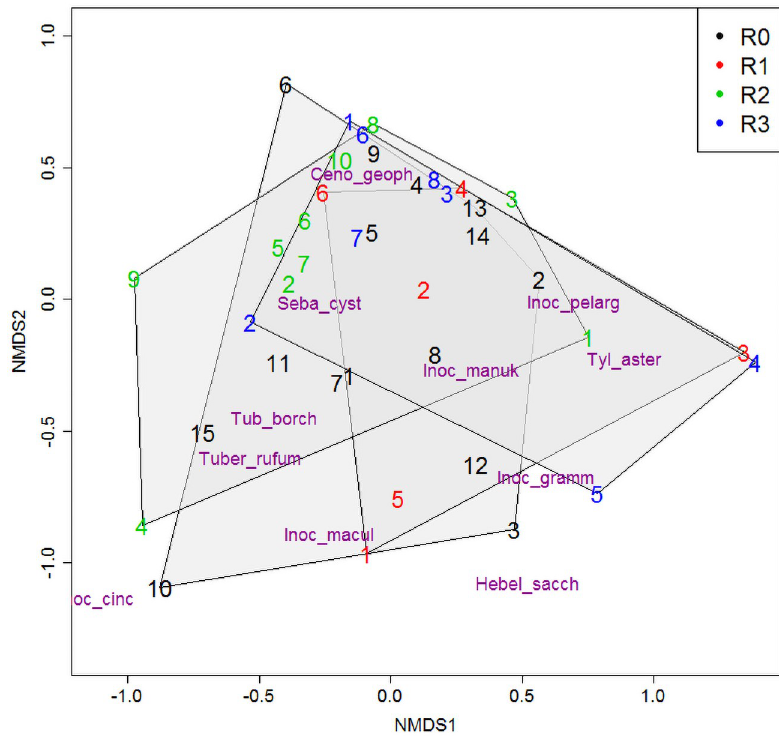
Fig 3. Non-metric MDS of the trees within Rolooff’s classes based on the ECM community. Convex hulls were drawn around each of the tree classes.